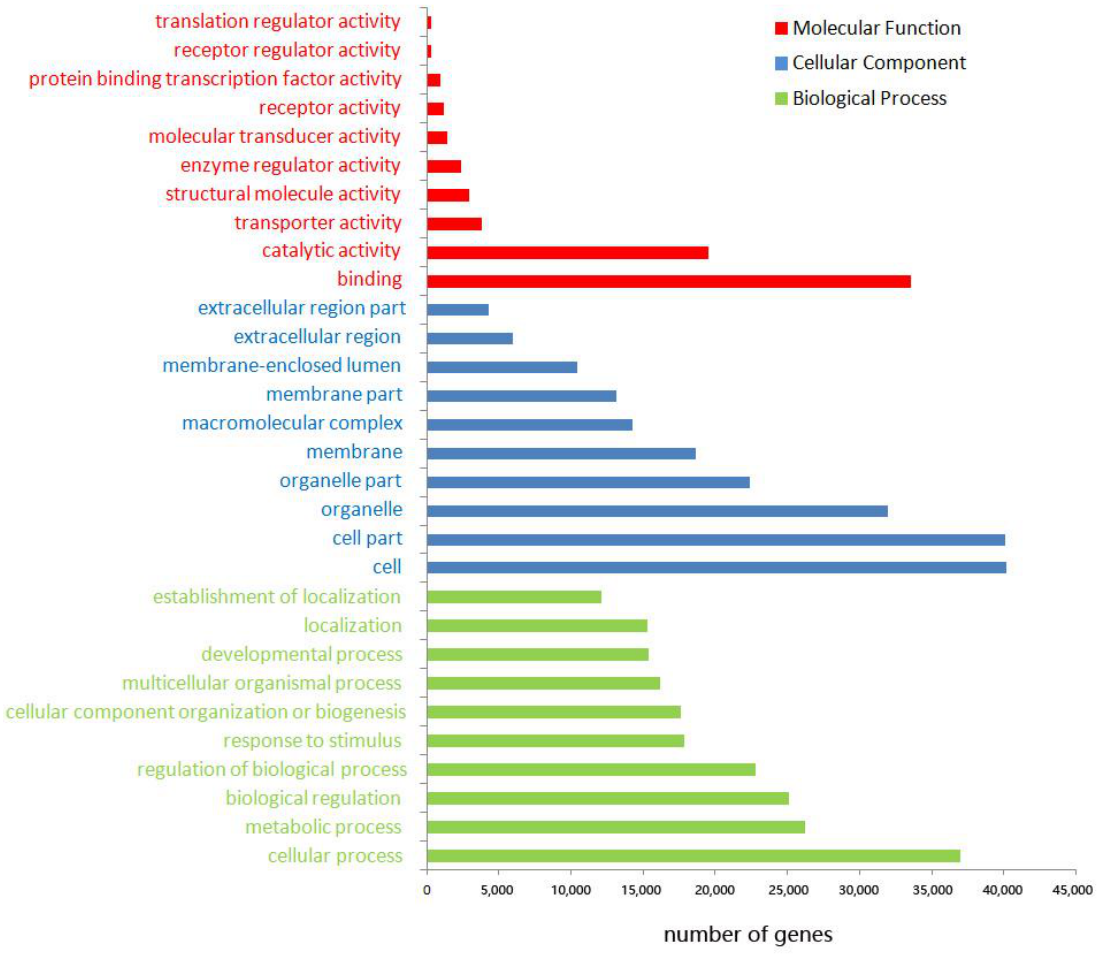
Figure 1. Function annotation of unique transcriptions of M. rosenbergii by GO database.